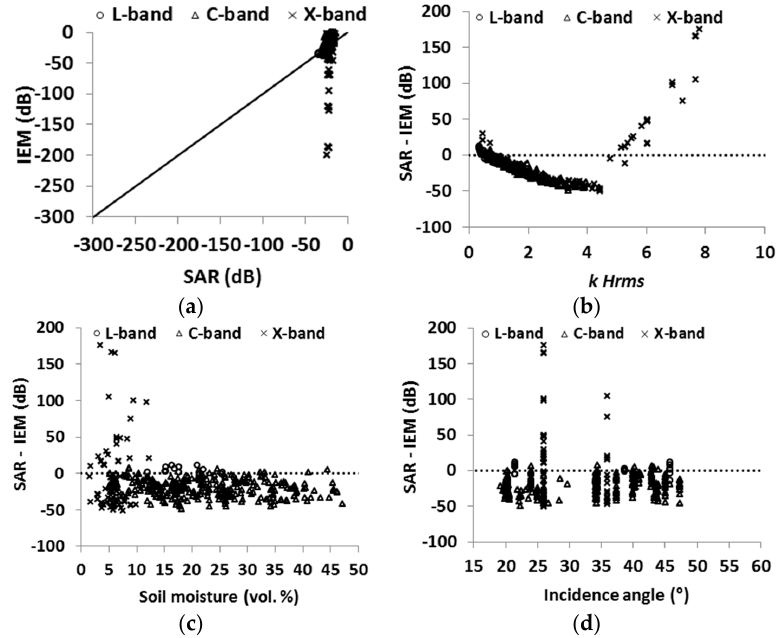
Figure 11. Comparison between backscattering coefficients derived from SAR images and those estimated from IEM at HV polarization using ECF. ( a ) IEM simulations vs. SAR data; ( b ) difference between SAR signal and IEM vs. soil roughness ( kHrms ); ( c ) difference between SAR signal and IEM vs. soil moisture ( mv ); ( d ) difference between SAR signal and IEM vs. incidence angle.